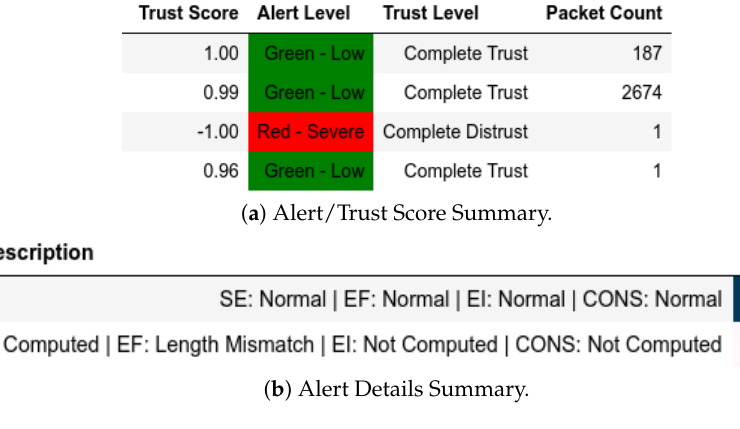
Figure 27. ATENA H2020 dataset internal test- H a in MitM capture-baseline replay to final